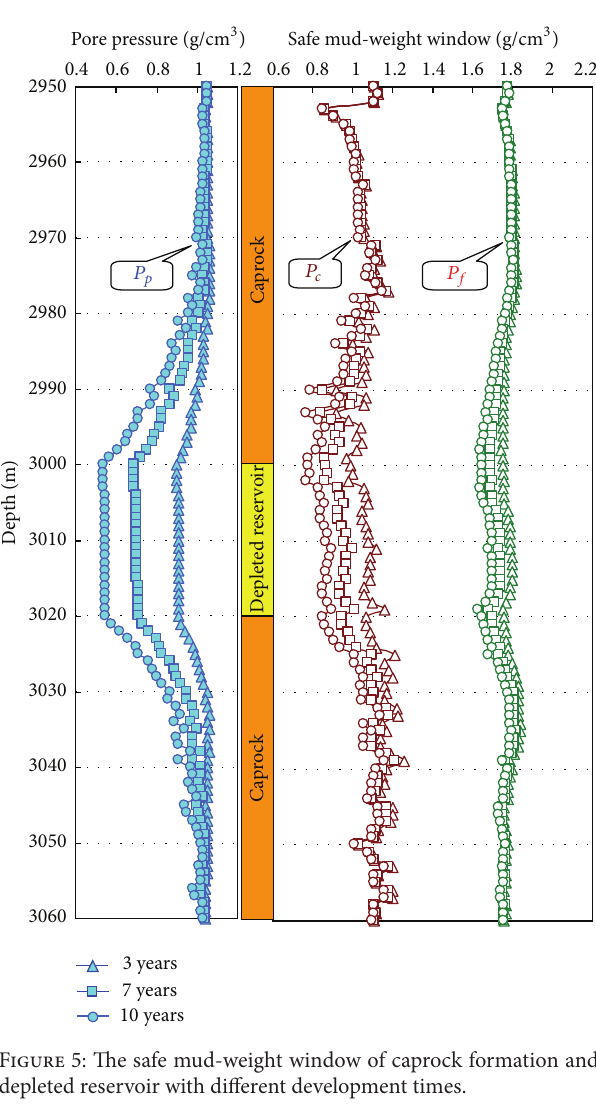
Figure 5: The safe mud-weight window of caprock formation and depleted reservoir with different development times.